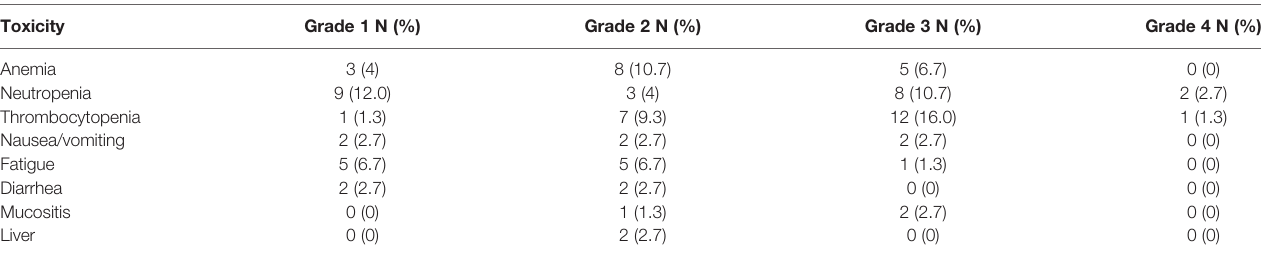
TABLE 3 | Toxicity in melphalan-treated patients.